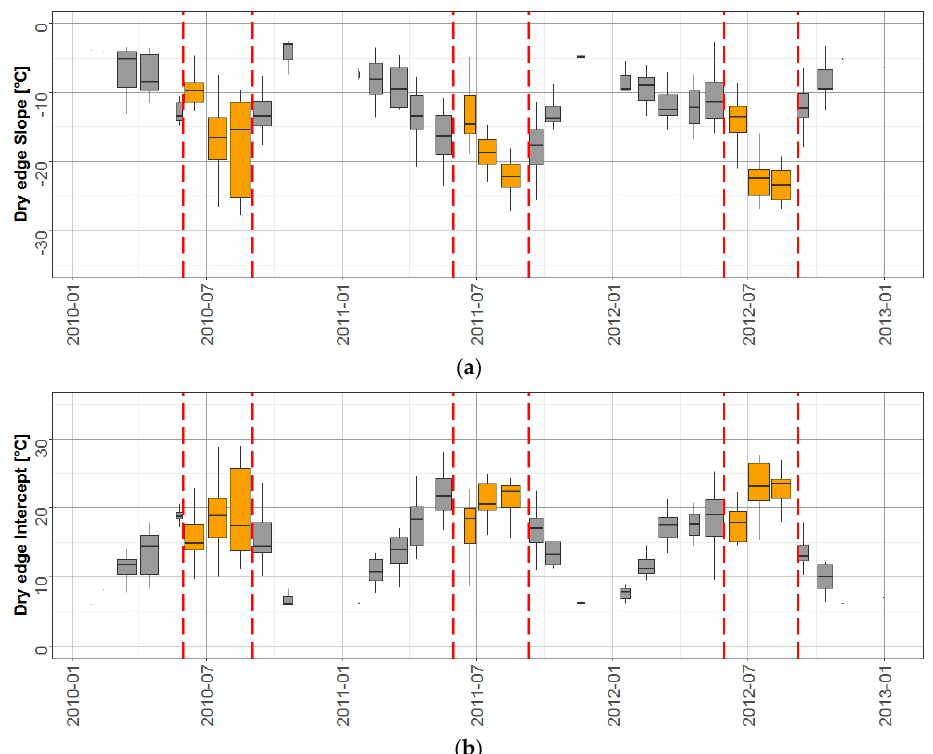
19 of 24 Figure A4. Values of estimated T s over the two eddy towers for months and QF. Appendix C Seasonal trends of the parameters of the regression line representing the dry edge are shown in Figure C1. Monthly statistics of the slope and intercept are plotted against time with a box-plot representation. The summer months, from June to August, when temperatures are higher and water shortage could became an issue, are highlighted by yellow boxes in the graphs and delimited by red dotted lines. With the onset of the growing season in late spring and the beginning of the summer period, dry edge becomes gradually steeper reaching average minimum slope between July and August as also displayed by scatter plots in Figure 6. Dry edge lines with high intercept and low slopes indicates dates characterized by greater difference between air T a and surface T s temperature, a thermal condition typical of hot months when stressed pixels are present in the area together with well- watered areas; in these months of the year a wider range of thermal conditions of crops is reached. Winter and spring months show, on average, dry edges with smaller slopes and intercepts close